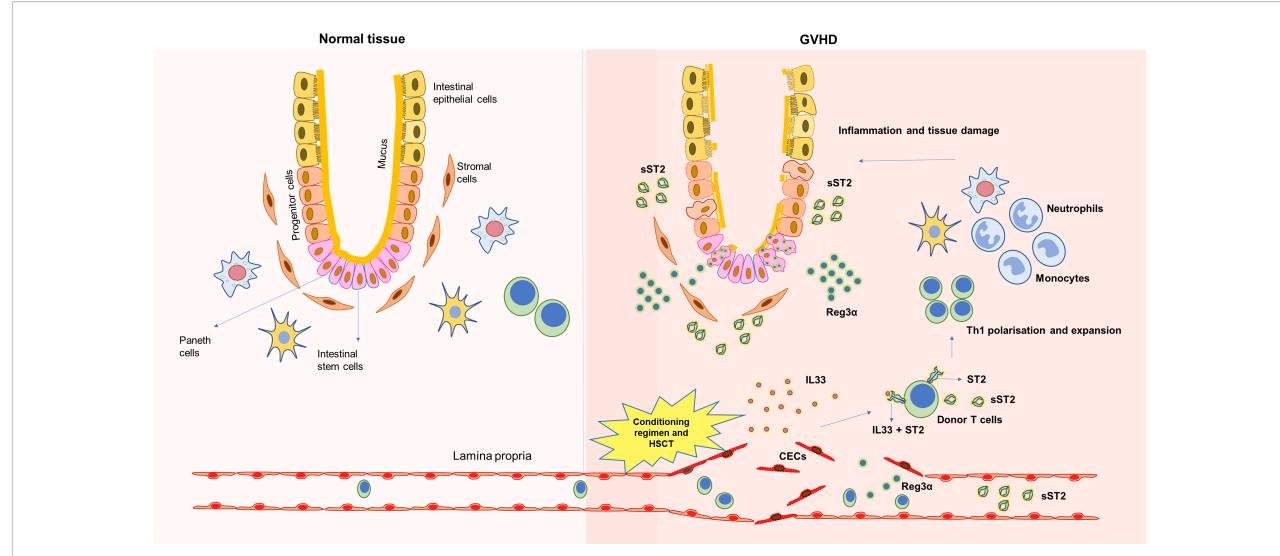
FIGURE 1 Underlying tissue damage during GVHD and release of soluble biomarkers. HSCT transplant procedures, including conditioning regimen, damage underlying endothelium, in fl ames the tissue and releases soluble factors that could be used as biomarkers during